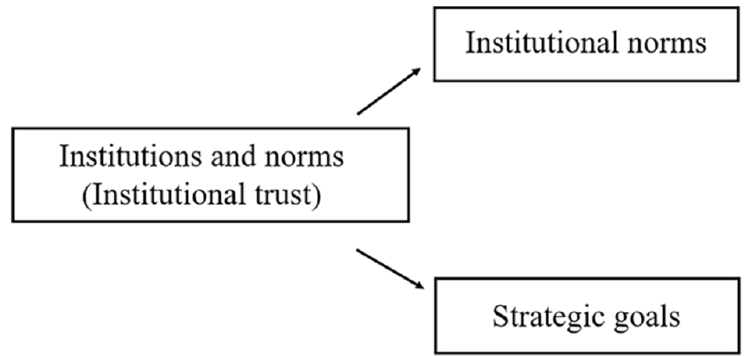
Figure 1. The structural dimension of social capital.